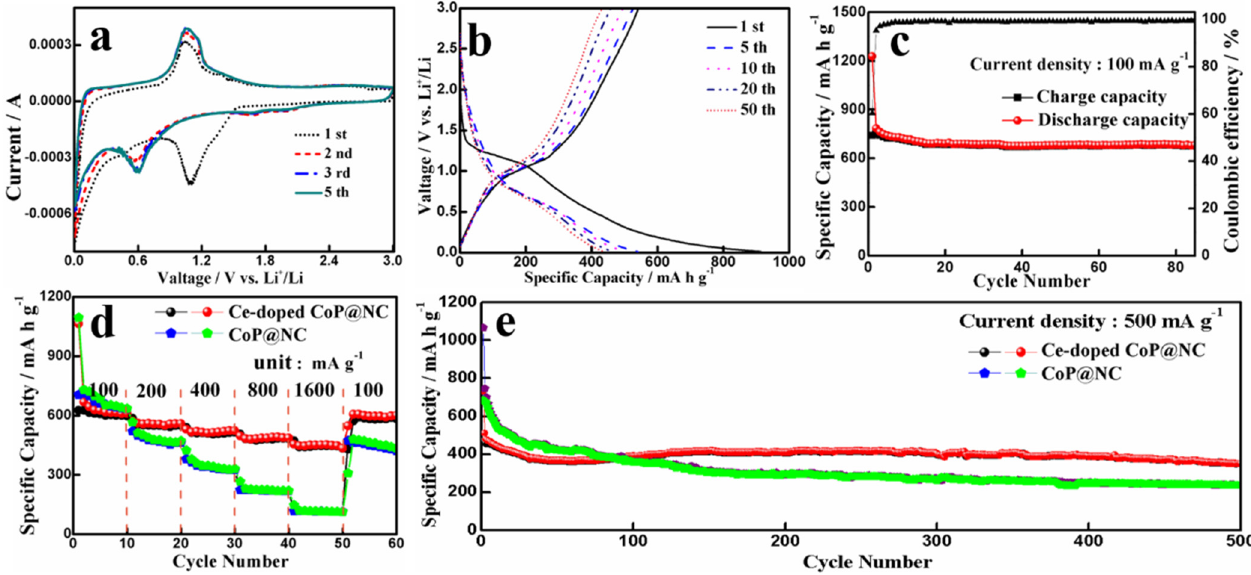
Figure 5 . Electrochemical characterization for lithium storage electrodes. ( a ) CV of Ce-doped CoP@NC at a scan rate of 0.1 mV s − 1 in the voltage range of 0.01-~ 3.0 V. ( b ) Galvanostatic